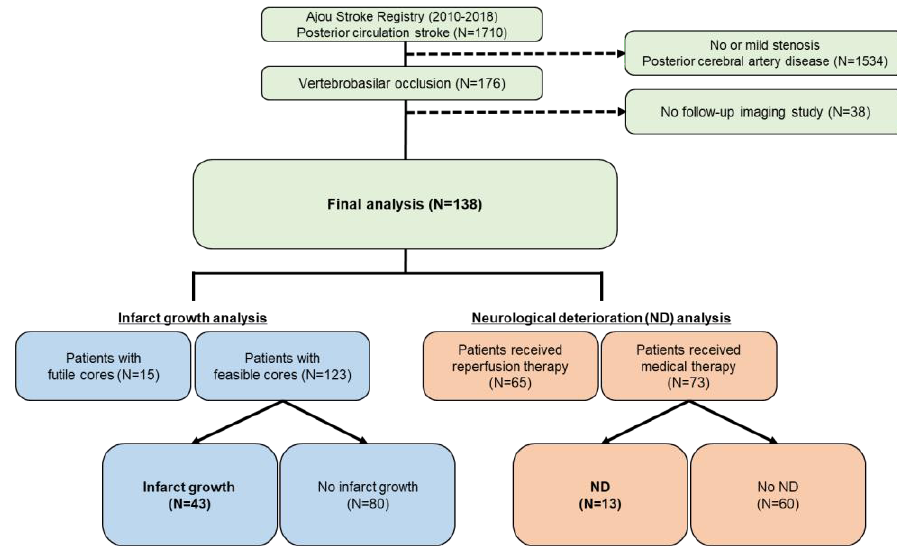
Figure 1. Flow chart of the patient selection process is provided in this flowchart. ND, neurological